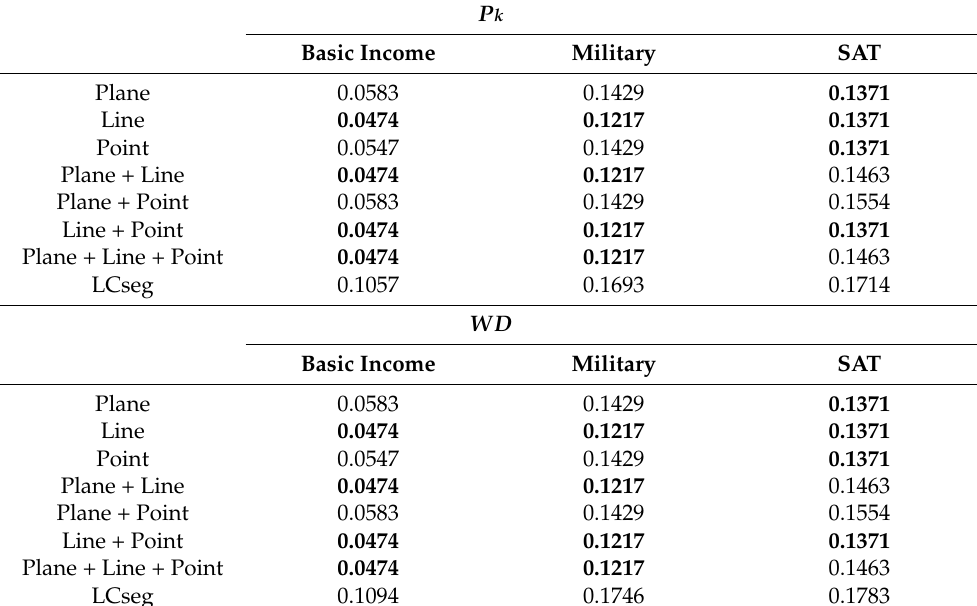
Table 7. CSseg P k and WD values with the weight of topic guide of moderator set to